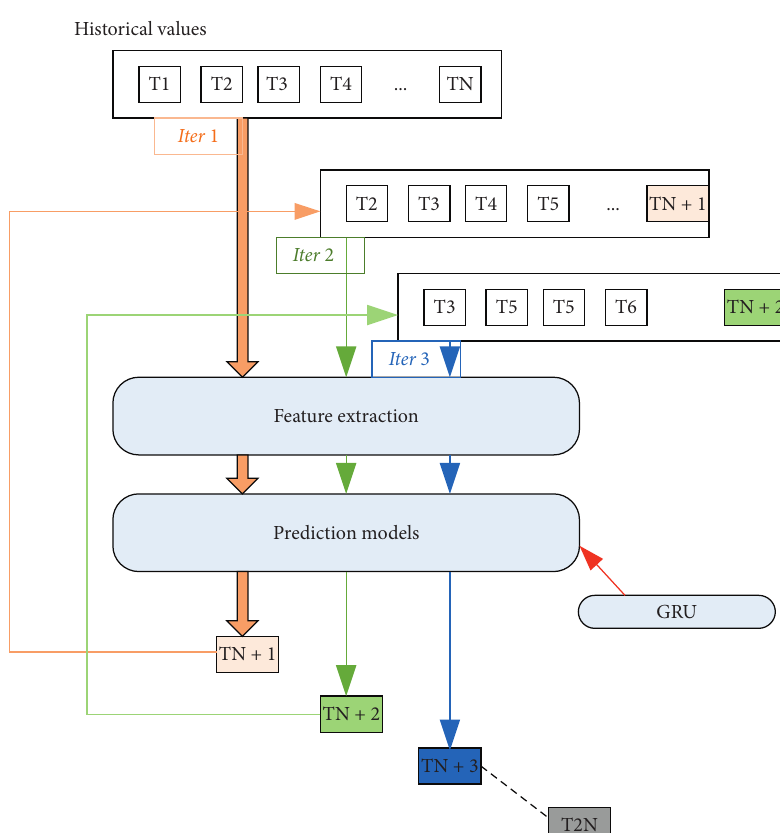
Figure 4: Architecture of the industrial heritage cloud platform based on Hadoop technology.